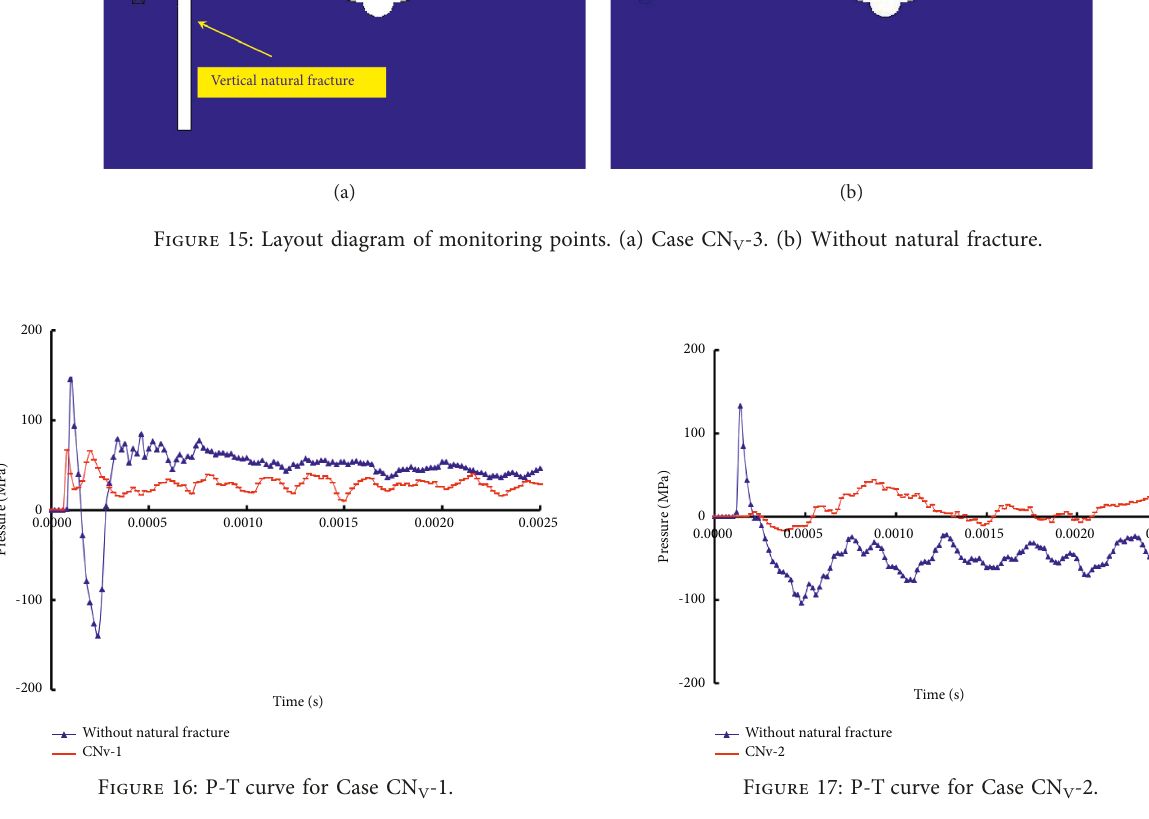
Figure 17: P-T curve for Case CN